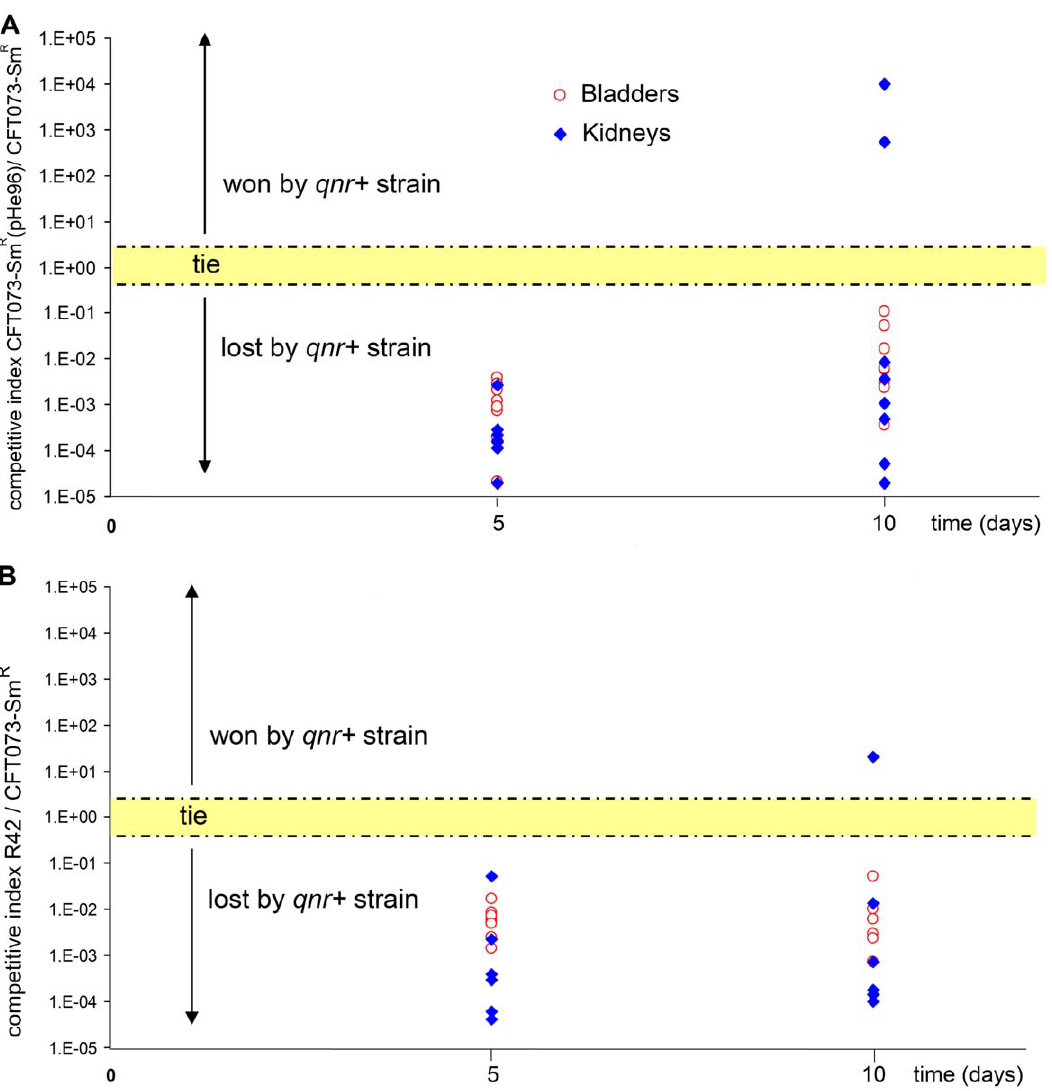
Figure 4. Reduced fitness observed after pHe96 acquisition in competitive infections in absence of antimicrobial exposure. Each symbol represents the ratio (number of CFU for the qnr -positive strain/number of CFU for the qnr -negative isogenic strain) in organs (blue diamond=kidneys, red circle=bladder), collected five and ten days after inoculation of a 1:1 mix of the two strains. Part A: competition experiments opposing E. coli CFT073-Sm R ( qnr 2 ) and E. coli CFT073-Sm R (pHe96) ( qnrA3 + ). Twenty mice were inoculated, 19 bladders and 16 pairs of kidneys were efficiently infected. Competition was lost 33 times by E. coli CFT073-Sm R (pHe96) ( qnrA3 + ), and won only 2 times (p , 0.0001). Part B: competition experiments opposing E. coli CFT073-Sm R ( qnr 2 ) and E. coli CFT073-Sm R (pHe96) variant ‘‘R42’’ ( qnrA3 + ). The R42 variant was selected from kidneys that were infected by E. coli CFT073-Sm R (pHe96). Twenty mice were inoculated, 18 bladders and 16 pairs of kidneys were efficiently infected. Competition was lost 33 times by the qnrA3 -positive strain with only one won (p ,